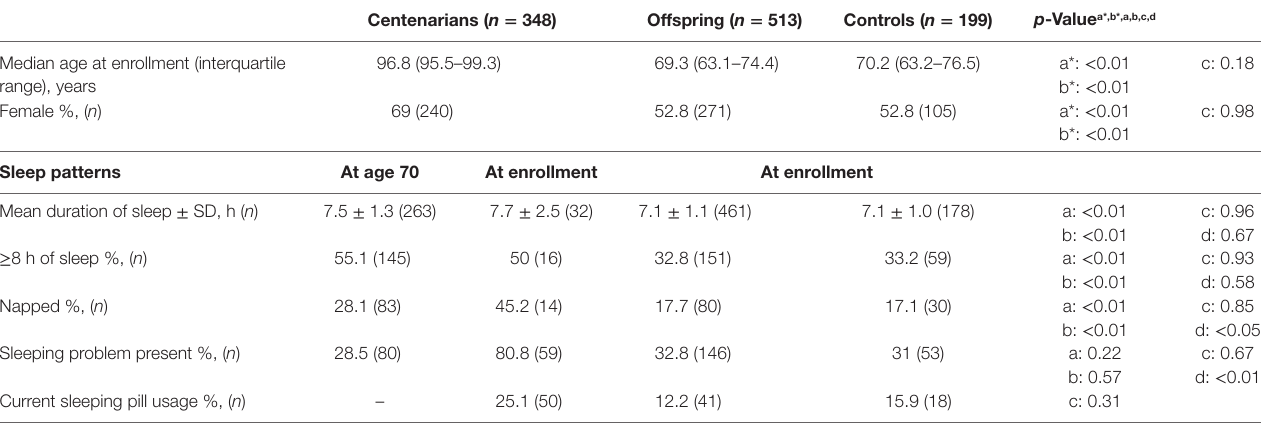
TaBle 1 | Demographic characteristics and sleep patterns at enrollment and at age